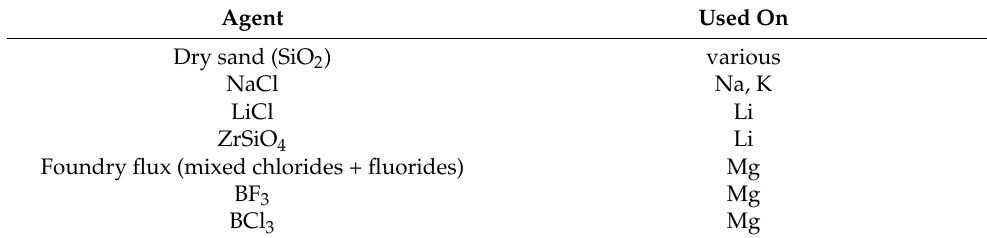
Table 1. Extinguishing media for metal fires. Excerpt, reproduced from: [5]. Agent Used On Dry sand (SiO 2 )